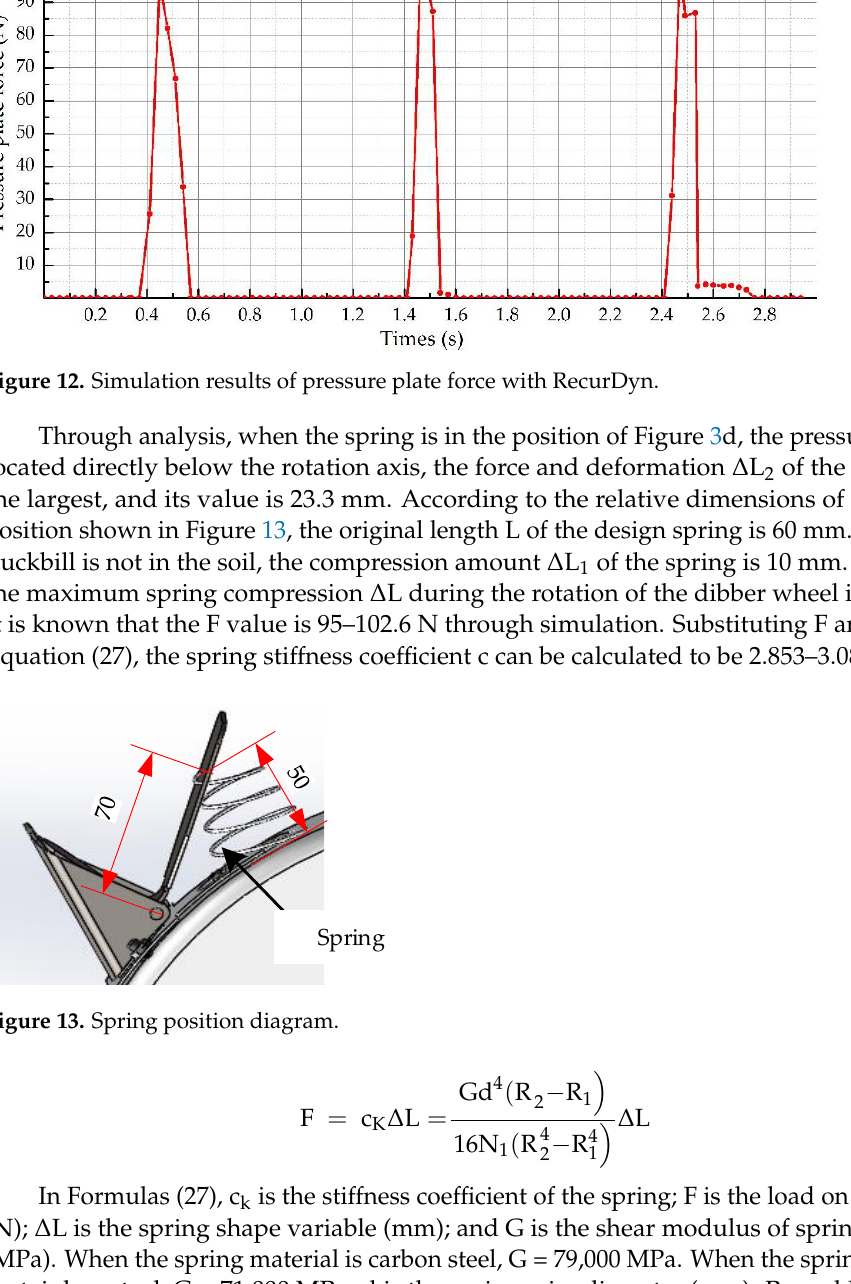
the pressure on the plate at the lowest point. The results show that when the dibber wheel